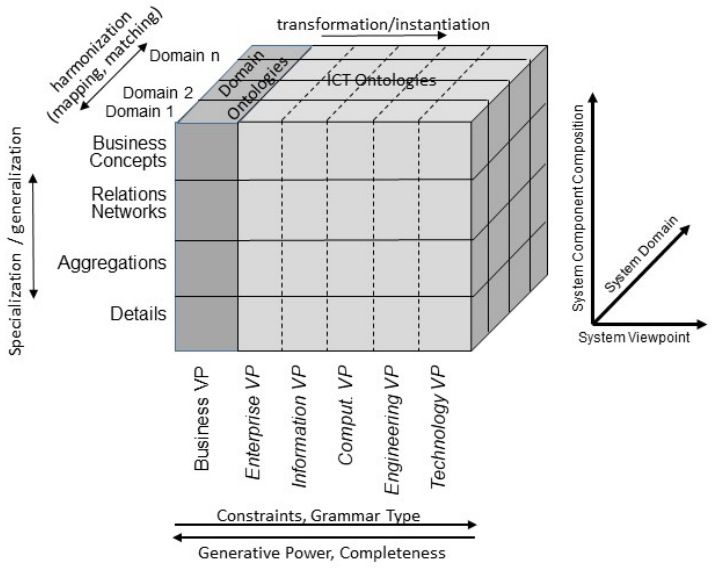
Figure 6. Generic business system representation according to ISO 23903, including the lan- guage/grammar characterization according to Chomsky [44].